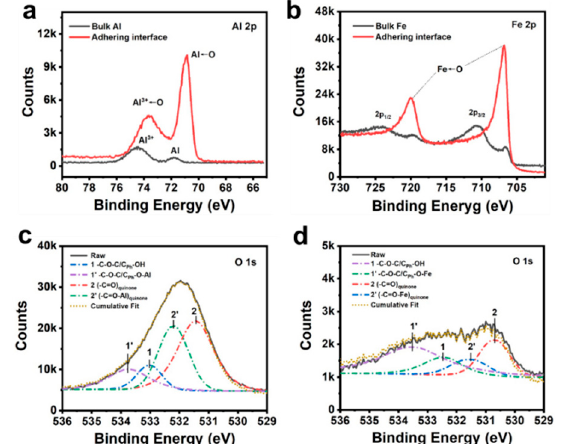
Figure 4. ( a ) Al 2p and ( b ) Fe 2p XPS spectra for the bulk substrate and the adhering interface; deconvoluted O 1s XPS spectra for ( c ) Al-adhering interface and ( d ) Fe-adhering interface.